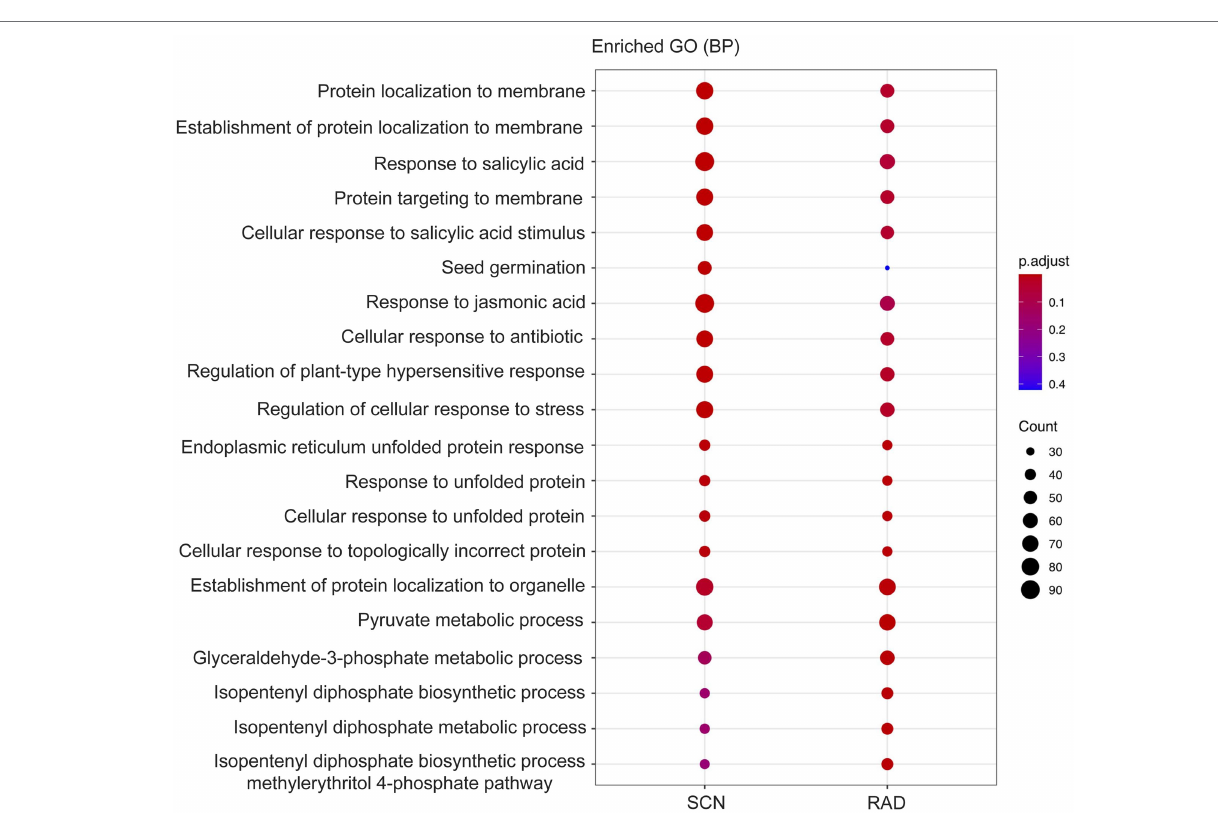
FIGURE 4 | GO enrichment (BP: biological process) of genes located 100 Kbp upstream and downstream of lncRNAs.